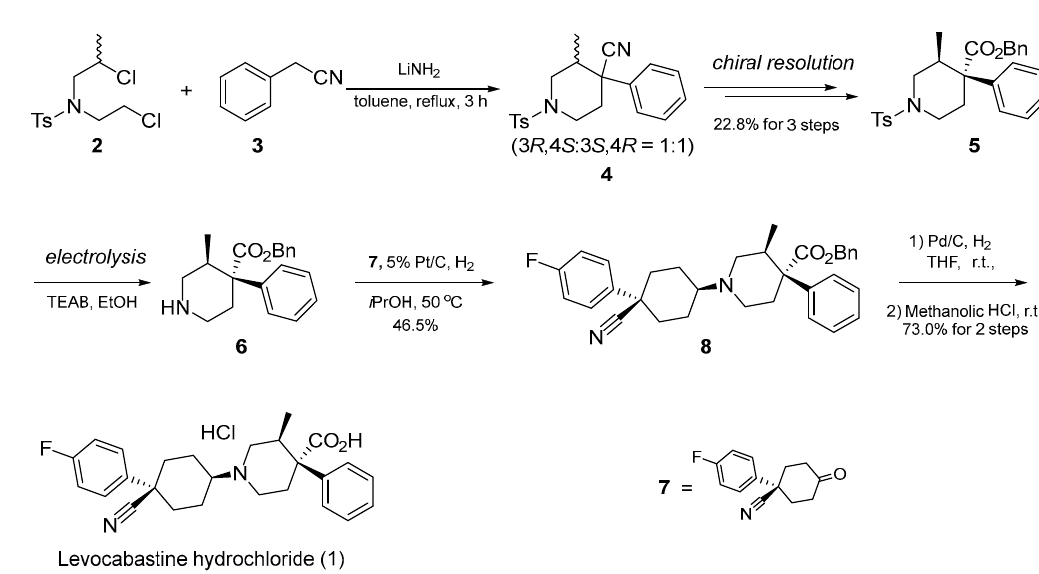
Figure 1. Representative H 1 receptor antagonists.